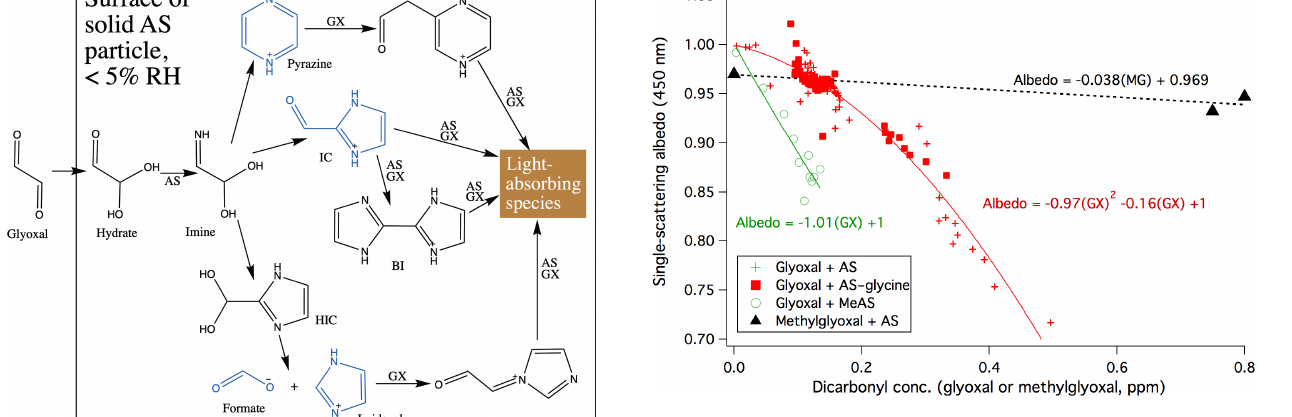
Figure 2. Top: anticorrelation of particle single-scattering albedo at 450nm (with a 3–7min delay) with gas-phase concentrations of glyoxal (Experiments 1, 3, and 4: dry AS, red + ; Experiment 2: dry AS–glycine, filled red squares; Experiment 5: dry MeAS, green circles) and methylglyoxal (black triangles, from De Haan et al., 2017) as measured by PTR-MS (Experiments 1–2 and methylgly- oxal data) or photoacoustic spectroscopy (Experiments